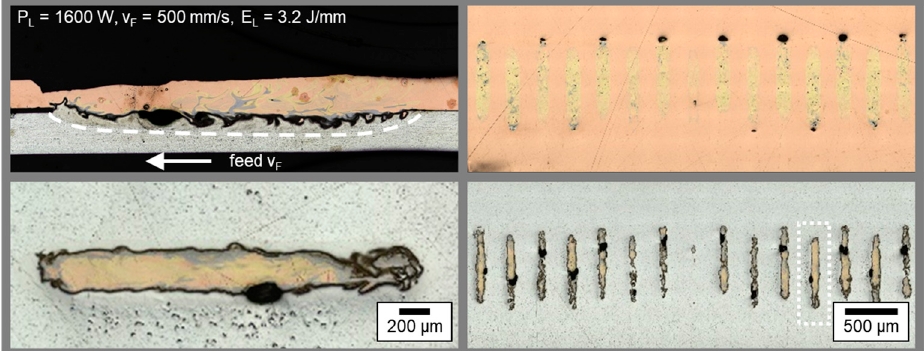
Figure 6. Micrographs (cross section and transversal section) of Cu-Al joint welded with P L = 1600 W and v F = 500 mm/s.